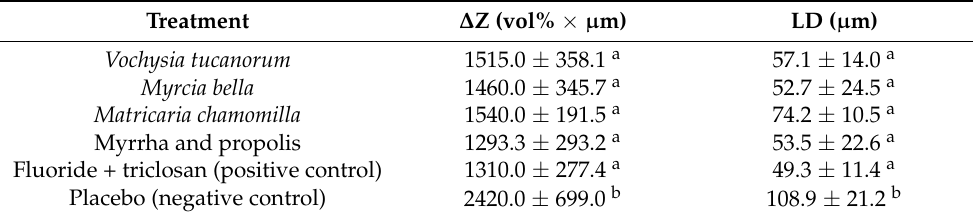
Different letters in the same column show statistical differences between groups. All parameters were compared using ANOVA/Tukey ( ∆ Z: p = 0.0011; LD: p <